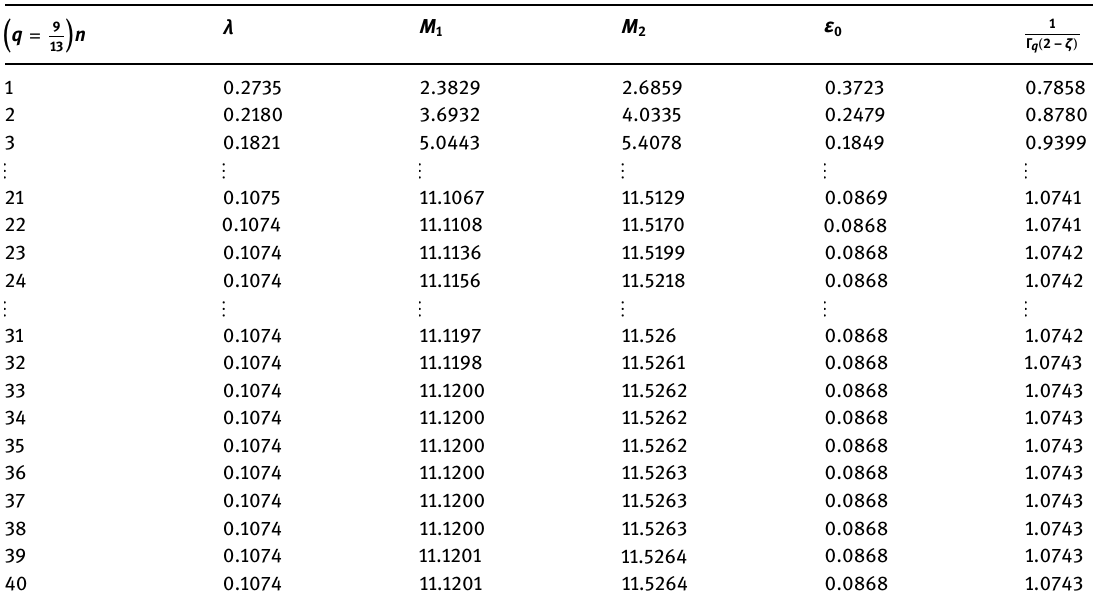
in Example 4.2 for ∈ t J and = (